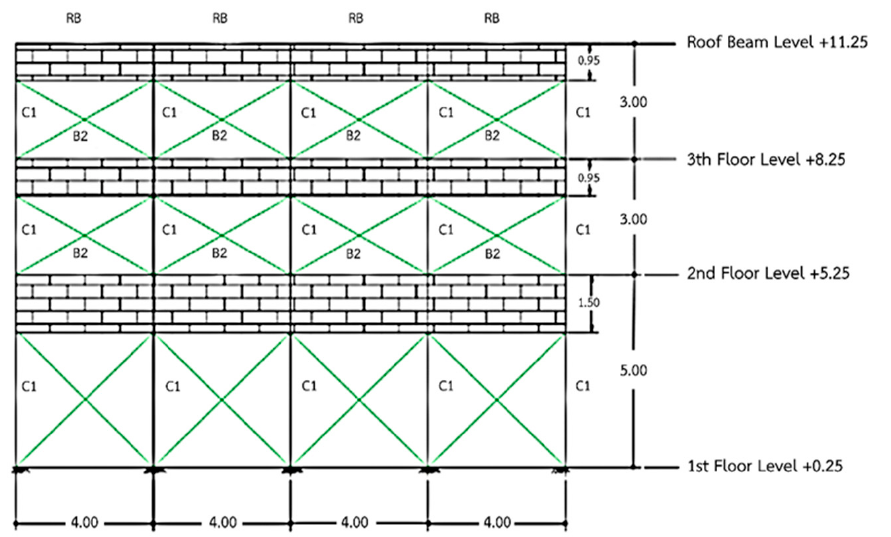
Figure 3. Part of the brick wall building frame.